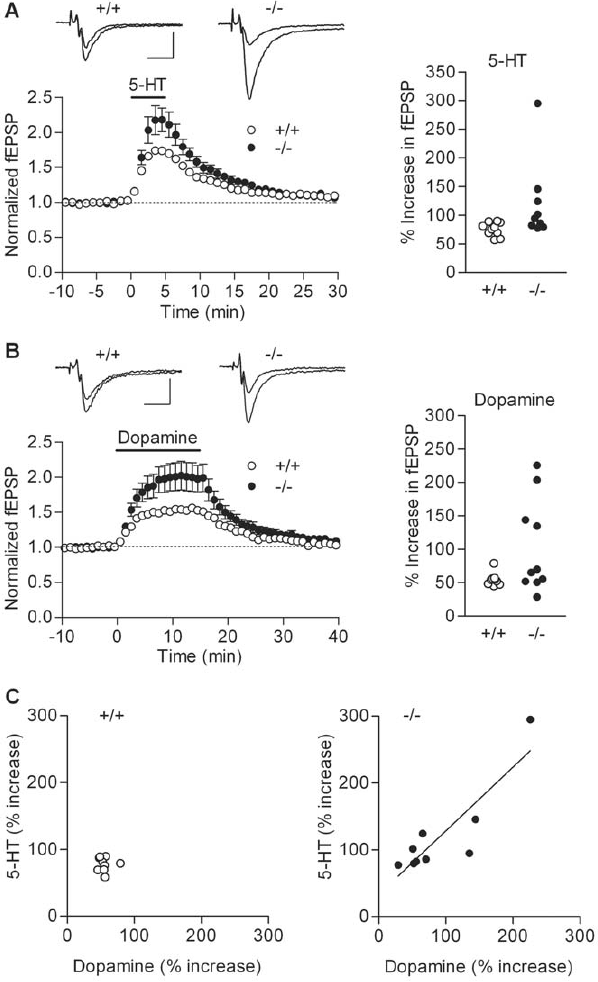
Figure 3. Altered monoaminergic synaptic modulations at mossy fiber synapse of sandy mice. (A) Left: Pooled data showing that serotonin-induced potentiation was enhanced in mutant mice ( 2 / 2 :120.8 6 23.1% increase, n=9) as compared with wild-type mice ( + / + :75.9 6 3.8% increase, n=10) ( p =0.0133). Serotonin (5-hydroxytripta- mine, 5-HT) was applied at a concentration of 5 m M in bath for 5 min as indicated by the bar. Sample recordings are averages of 9 consecutive fEPSPs recorded during baseline and at the peak of potentiation. Scale bar: 10 ms, 0.2 mV. Right: Individual data showing the magnitude of serotonin-induced potentiation. Each symbol represents a single mouse. (B) Pooled (left) and individual (right) data showing potentiation of mossy fiber synaptic transmission by 10 m M dopamine ( + / + : n=9; 2 / 2 : n=10). Some of mutant mice showed markedly enhanced synaptic potentiation, but there was no statistically significant difference ( p =0.1564). Scale bar: 10 ms, 0.2 mV. (C) Significant correlation between dopamine- and serotonin-induced synaptic potentiation in mutant mice (r 2 =0.7643, p =0.002), but not in wild-type mice (r 2 =0.00098, p =0.9362). Each symbol represents a single mouse.